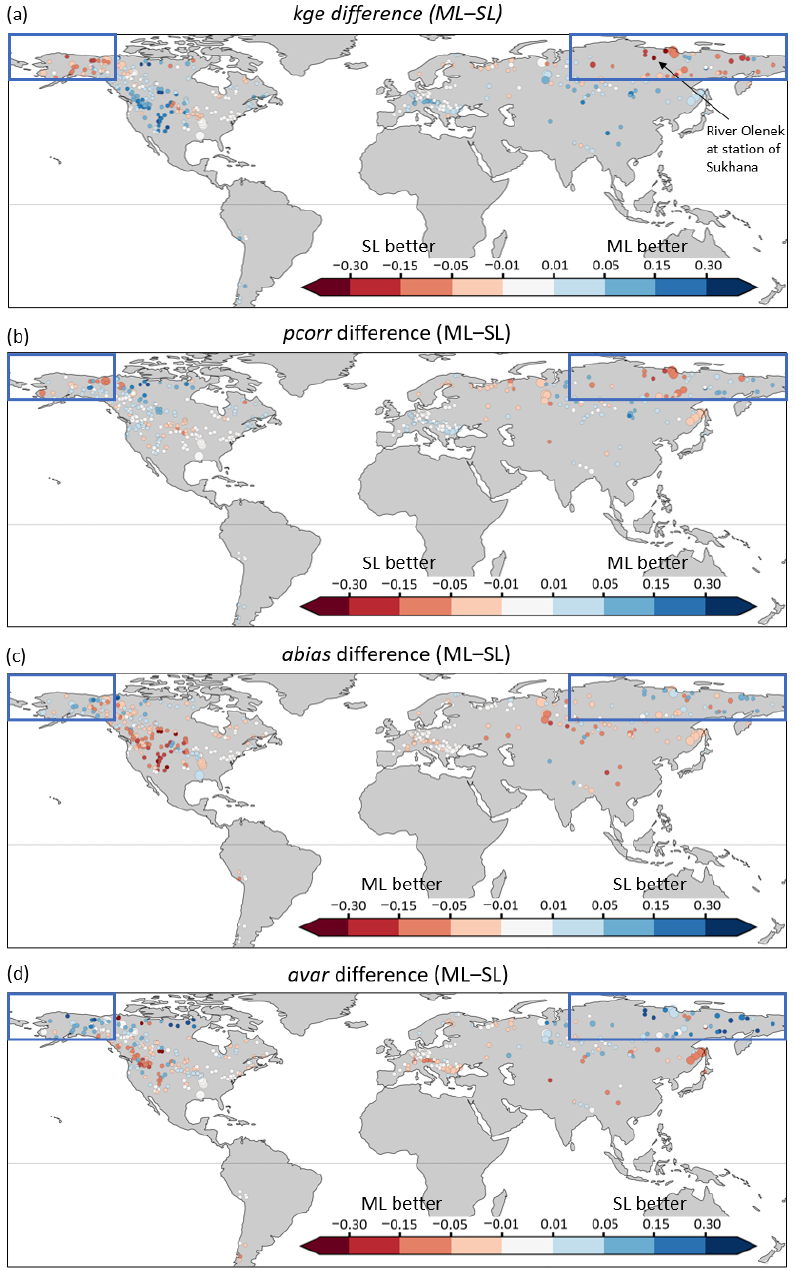
Figure 3. Difference of performance metrics between the default multi-layer (ML) and the single- layer (SL) snow scheme experiments, across all 453 stations, calculated on daily river discharge over 1980–2018. ( a ) Modified Kling–Gupta efficiency ( kge ) and ( b ) Pearson correlation ( pcorr ), ( c ) absolute bias ratio ( abias ) and ( d ) absolute variability ratio ( avar ). Improvements in ML are indicated by blue dots in ( a , b ), while by red dots in ( c , d ). Size of the dots represent the catchment area. The sensitivity area in the permafrost is shown by blue rectangles, while the test catchment on river Olenek at station Sukhana is indicated by black arrow in ( a ).